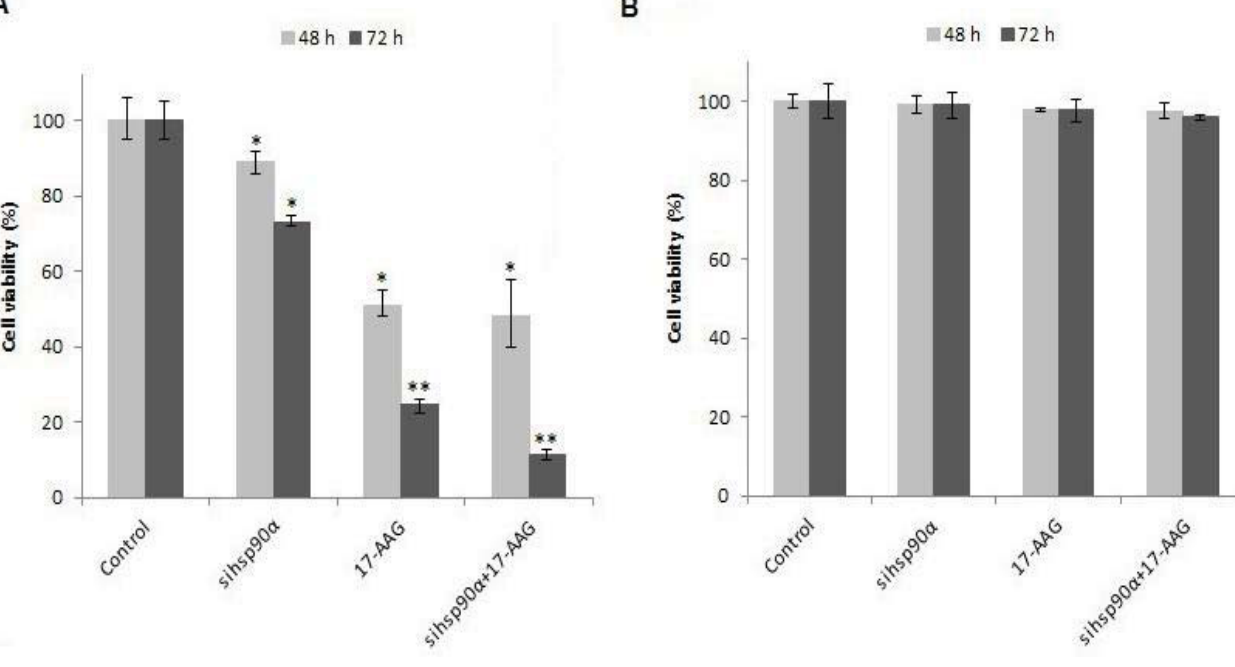
Figure 1. 17-AAG and sihsp90 (cid:2) effect on cell viability in vitro . Cell viability was monitored for cells treated with 17-AAG and sihsp90 (cid:2) after 48 h and 72 h in ( A ) U87-MG and ( B ) SVGp12. Control represent untreated cells, sihsp90 (cid:2) represent cells treated with hsp90 (cid:2) specific siRNA. sihsp90 (cid:2) + 17-AAG represents concurrent assays where the cells were treated with 17-AAG and sihsp90 (cid:2) for either 48 h or 72 h. * p ≤ 0.05 and ** p ≤ 0.001 were considered statistically significant (Data values are mean ± SD, n = 3).